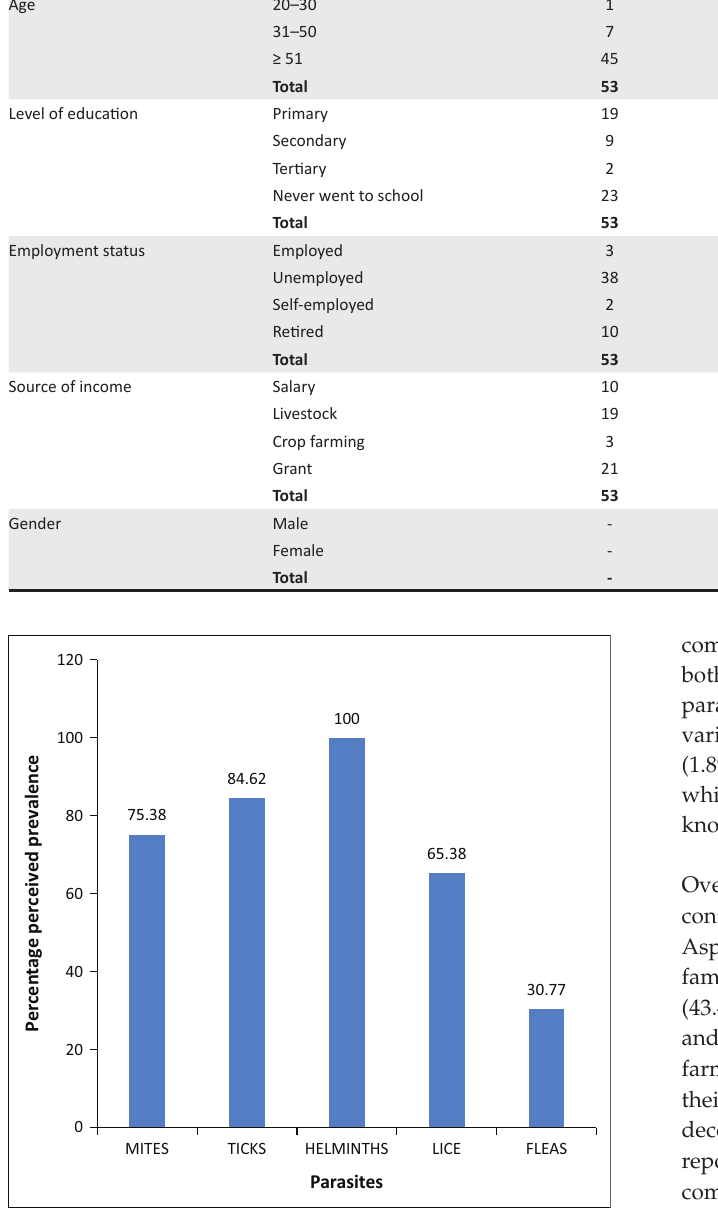
FIGURE 1: Perceived prevalence of parasites in Chris Hani District in Eastern Cape Province, South